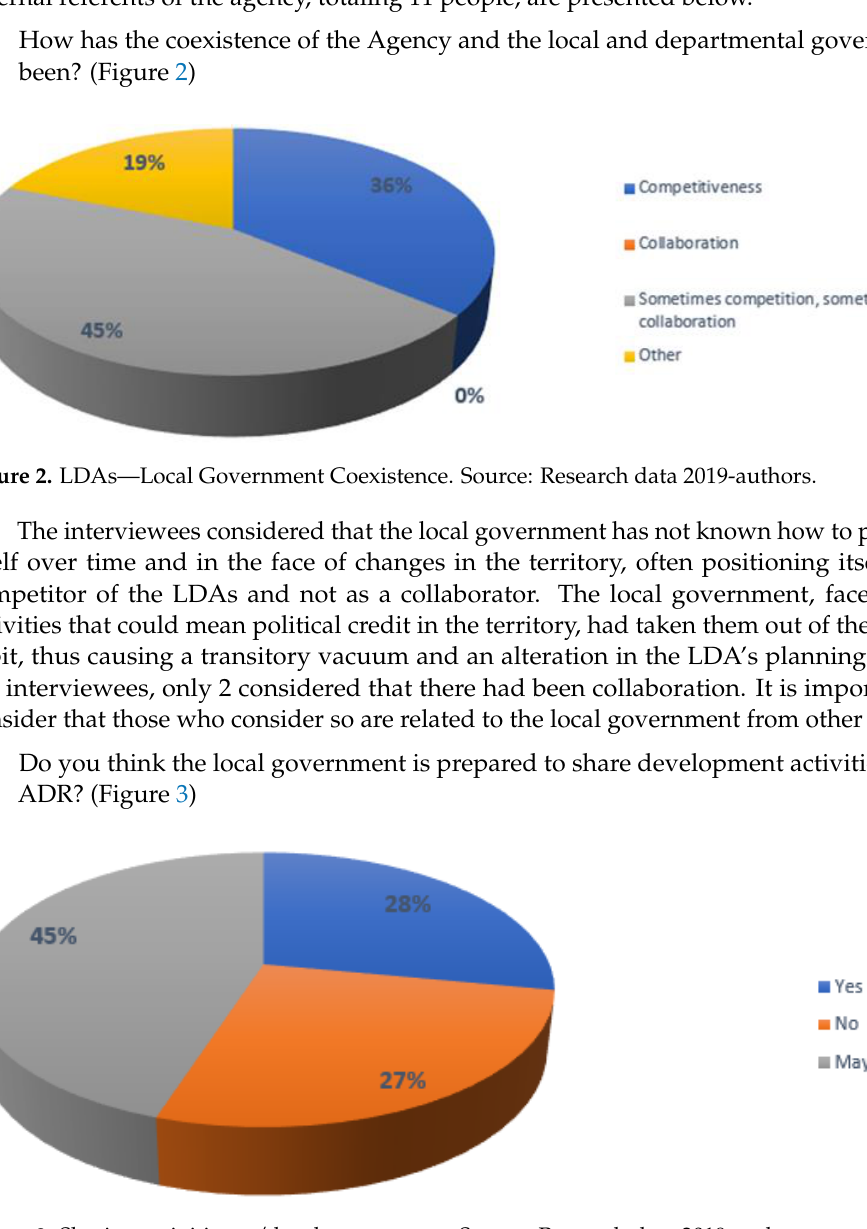
Figure 3. Sharing activities w/ local government. Source: Research data 2019-authors.